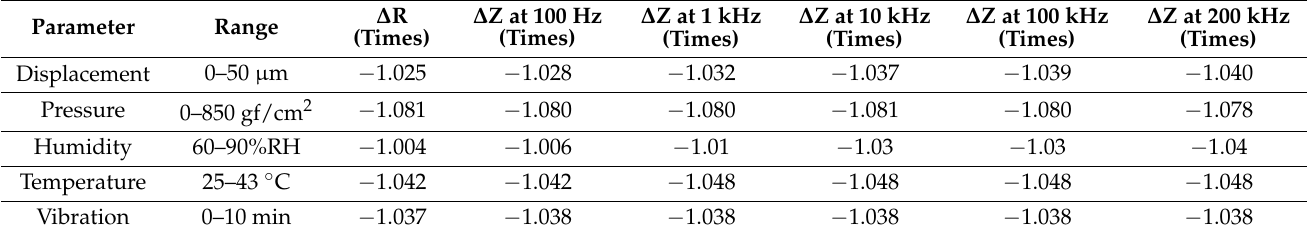
Table 1. Summary of the results showing the effect of various parameters on the resistor.